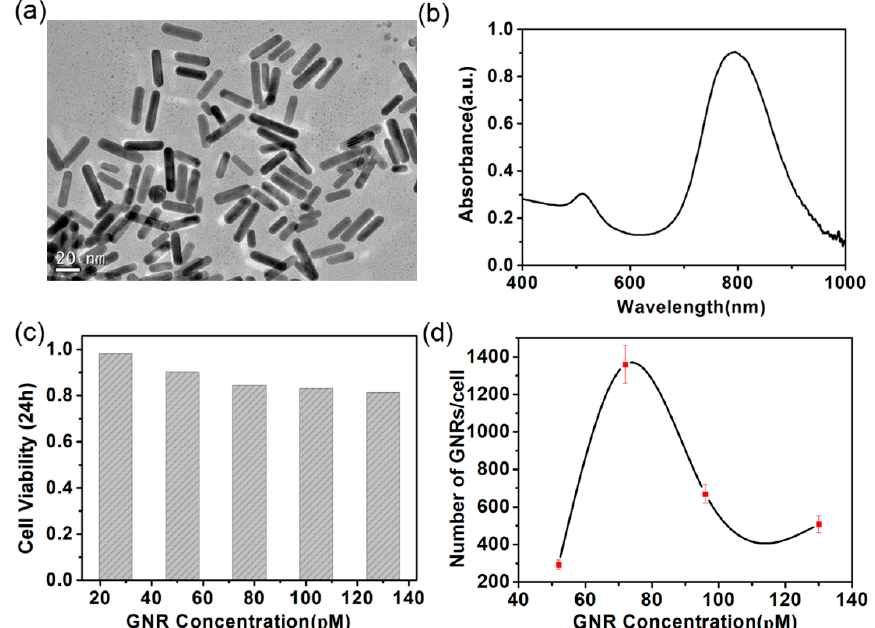
Figure 1. ( a ) TEM image of the synthesized gold nanorods (GNRs); ( b ) absorption spectrum of the GNRs dispersed in water; ( c ) cytotoxicity of GNRs against A375 cells; ( d ) uptake of the GNRs measured for A375 cells. Error bars represent the standard deviation of three experiments.